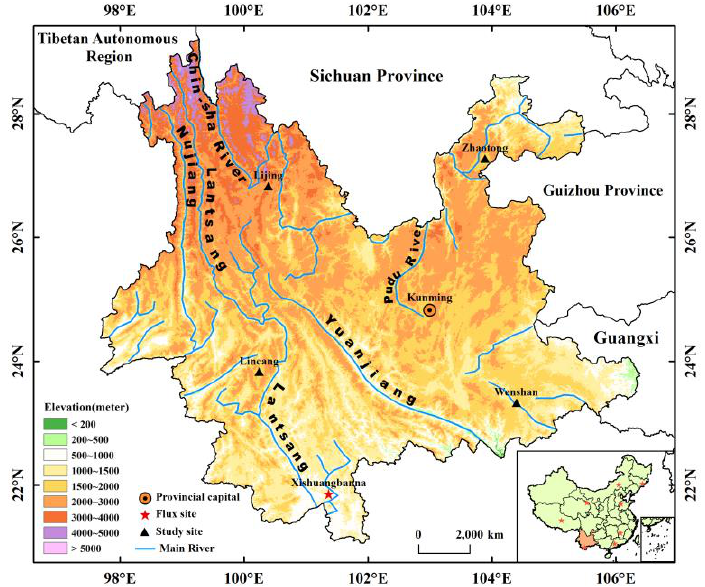
Figure 1. Overview map of Yunnan Province, China.